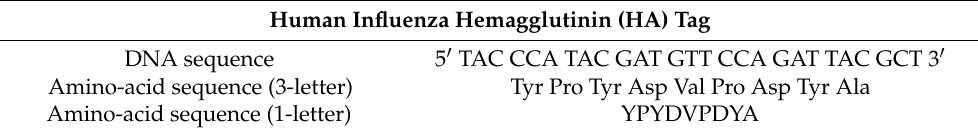
Table 1. DNA and amino-acid sequences of